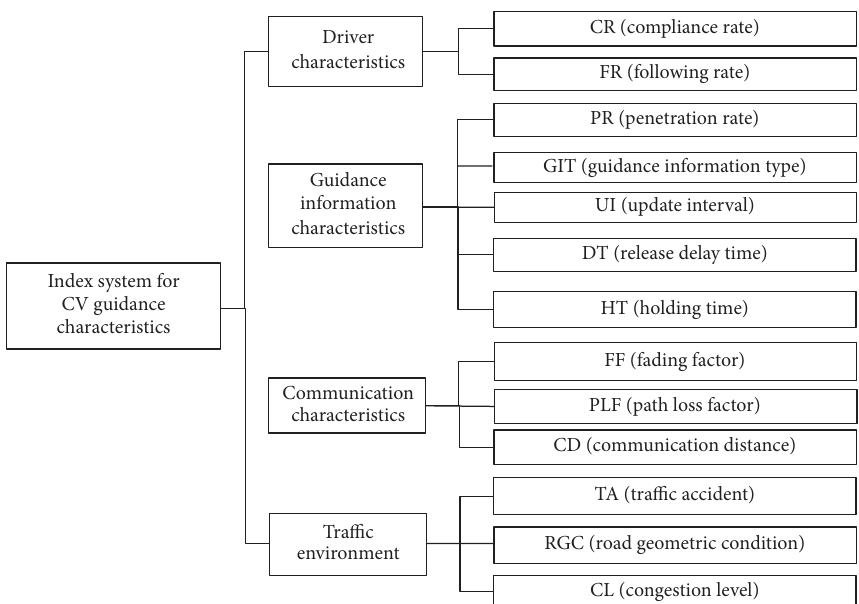
Figure 2: Indexes system for CV guidance